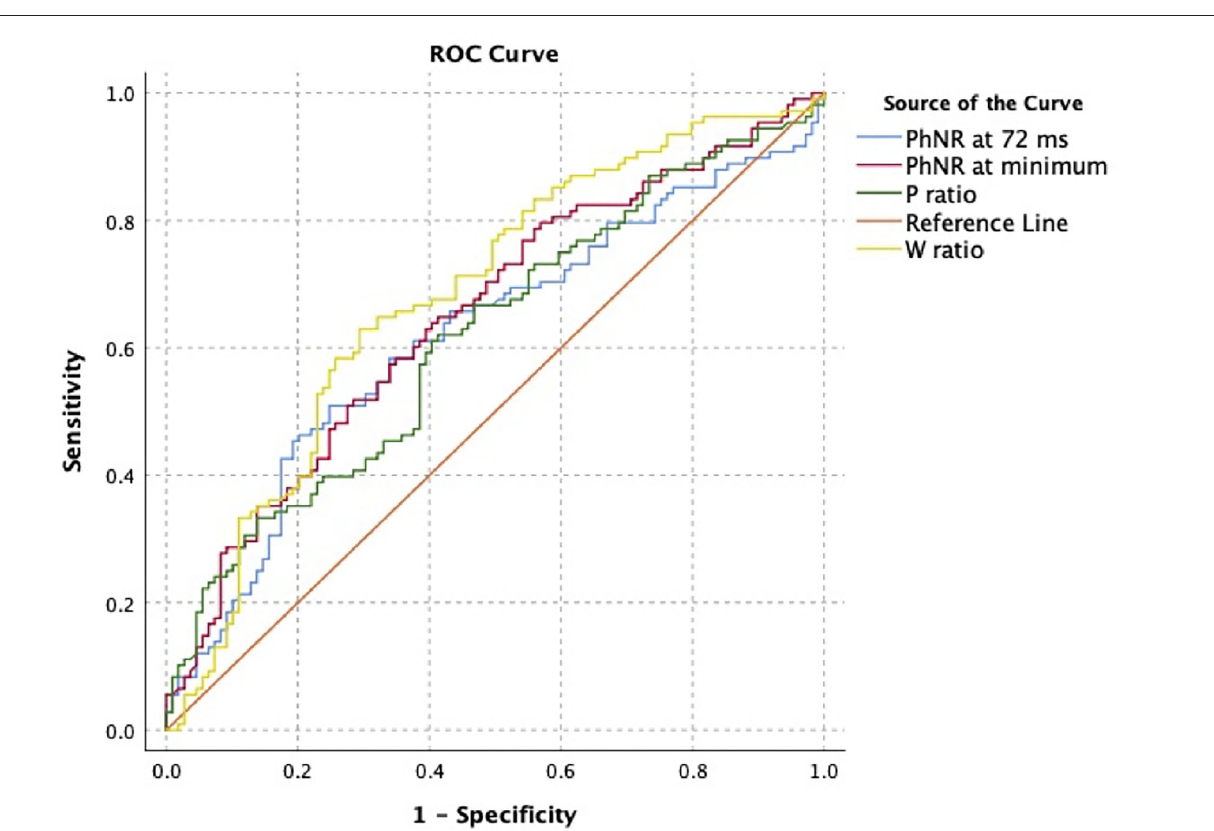
Frontiers in Medicine |